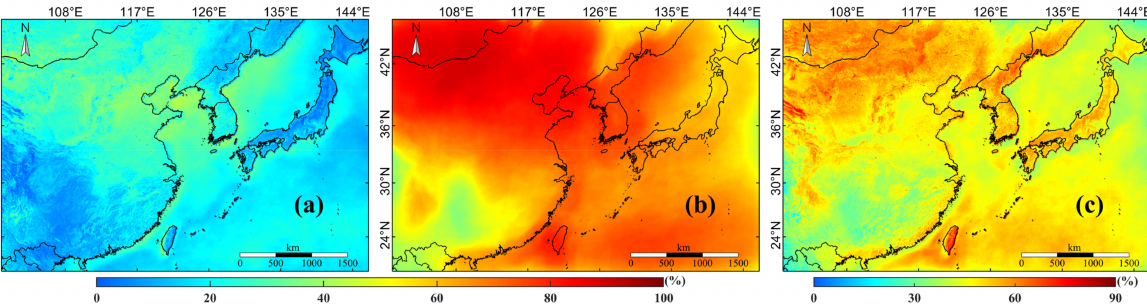
Figure 6. Spatial distribution of the annually averaged coverage ratio in 2017 for the ( a ) original Himawari-8 L2 AHI AOD datasets and ( b ) merged AOD datasets after GL-BME fusion, combined with ( c ) coverage improvement from original AHI AOD to merged